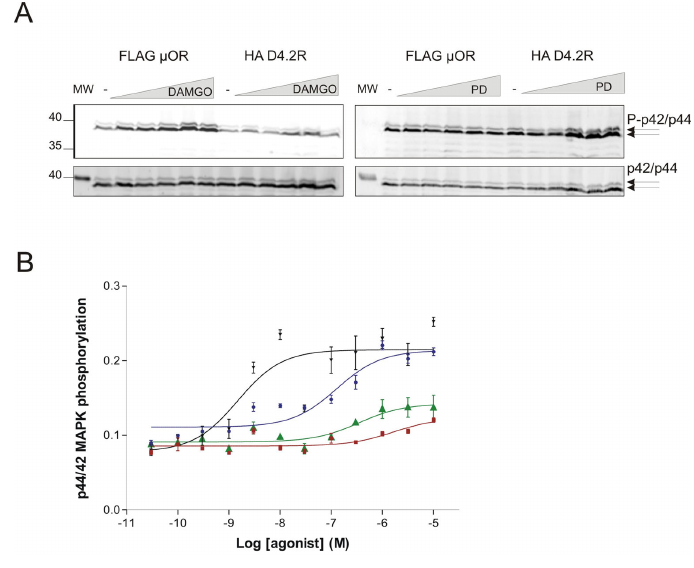
DAMGO (agonist of MOR); PD168.077 (specific agonist of D